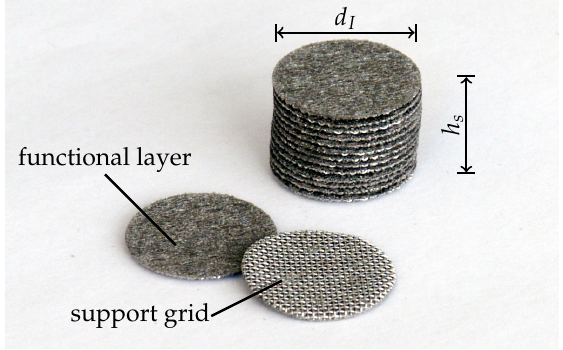
Figure 4. Punched specimens of SFF 100.